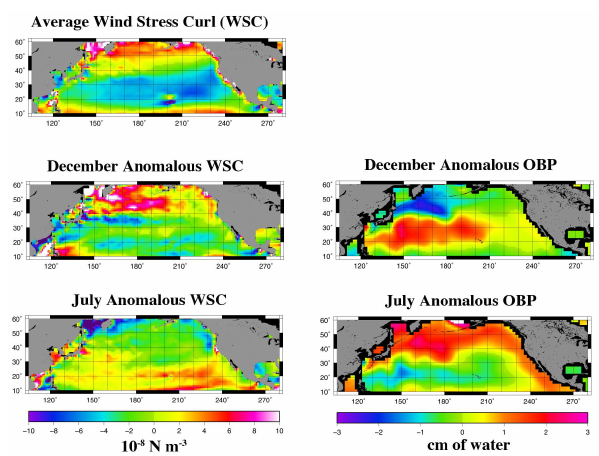
Fig. 1. Maps of WSC (left) and OBP (right) anomalies relative to a long-term mean (1992–2008) showing the average December anomaly (middle) and July anomaly (bottom). These represent the extreme anomalies of the seasonal cycle. The monthly averages were computed from the satellite observations and OMCT for all years from 1992 until 2008. The mean WSC is shown at the top left. The mean OBP will just reflect the mean water height of the ocean, and so is not